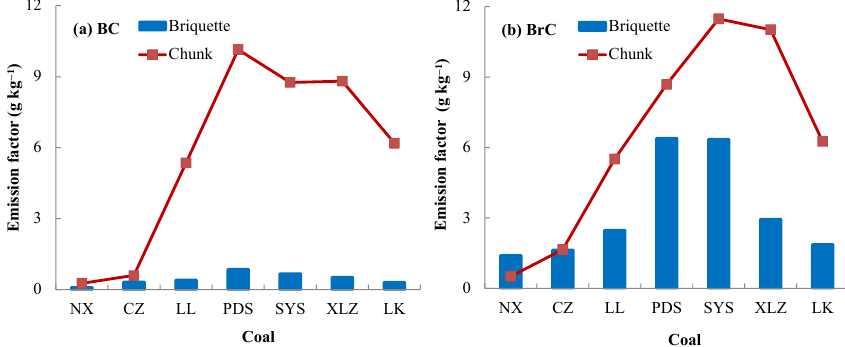
Figure 3. Effects of coal briquetting on black carbon (BC) and brown carbon (BrC)